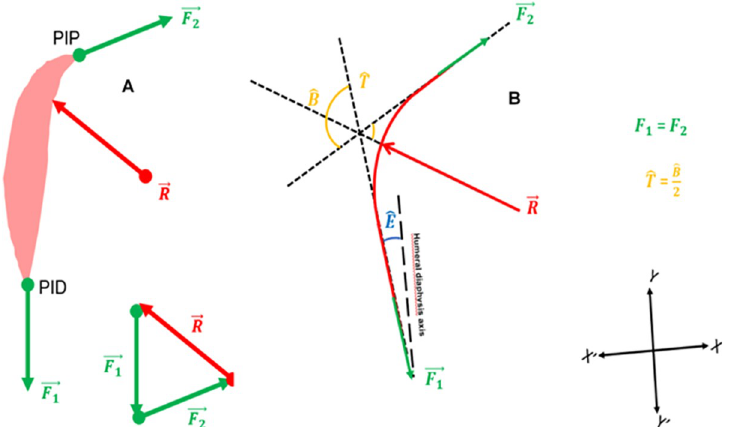
Fig 2. Biomechanical models used in the present study. (A) External forces and fundamental principles of the static � ! corresponds to the distal insertion Point (PID). F model. F 1 equivalent to the reaction force on the MD. (B) The Y’Y axis is parallel to the humeral diaphysis. ^ E represents the angle between MD muscle fiber orientation and the humeral diaphysis axis. ^ B represents the MD’s change in direction. ^ T ¼ ^ B = 2 . Only the normal F 1 and R vectors are used to compute the CER (forces directly in contact with the humerus). This model makes it possible to compute the CER using angle measurements.